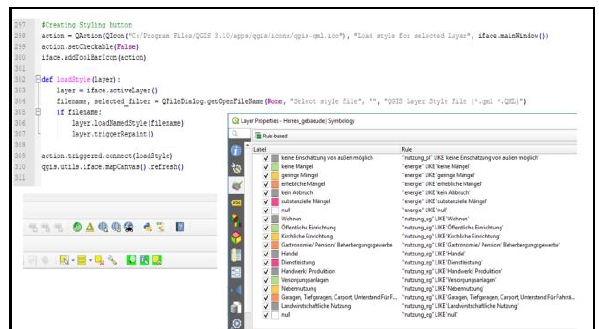
Figure 6 : Python script for style configuration.